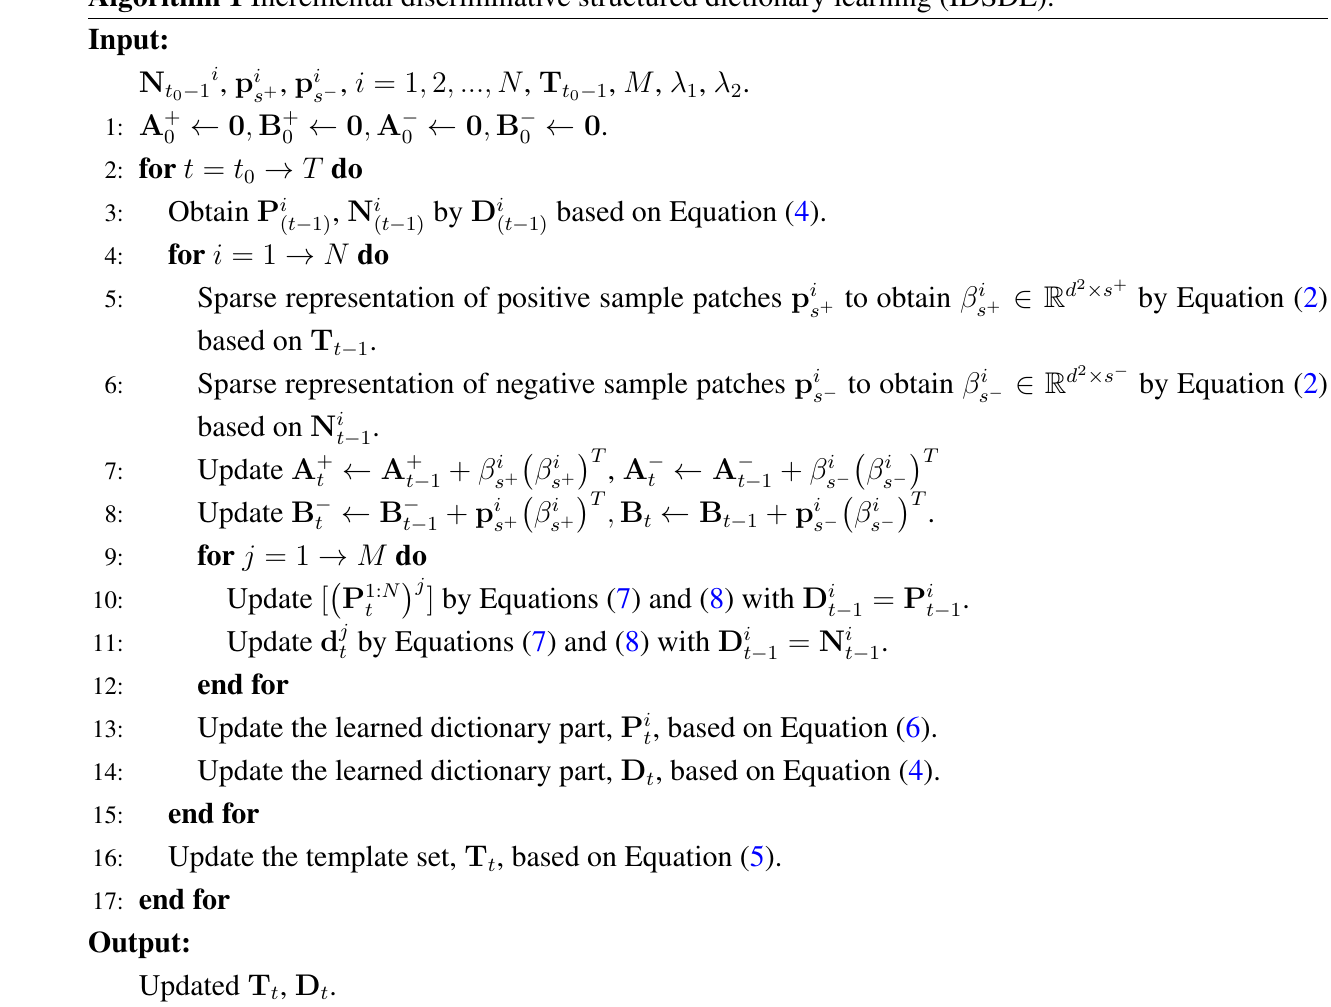
Algorithm 1 Incremental discriminative structured dictionary learning